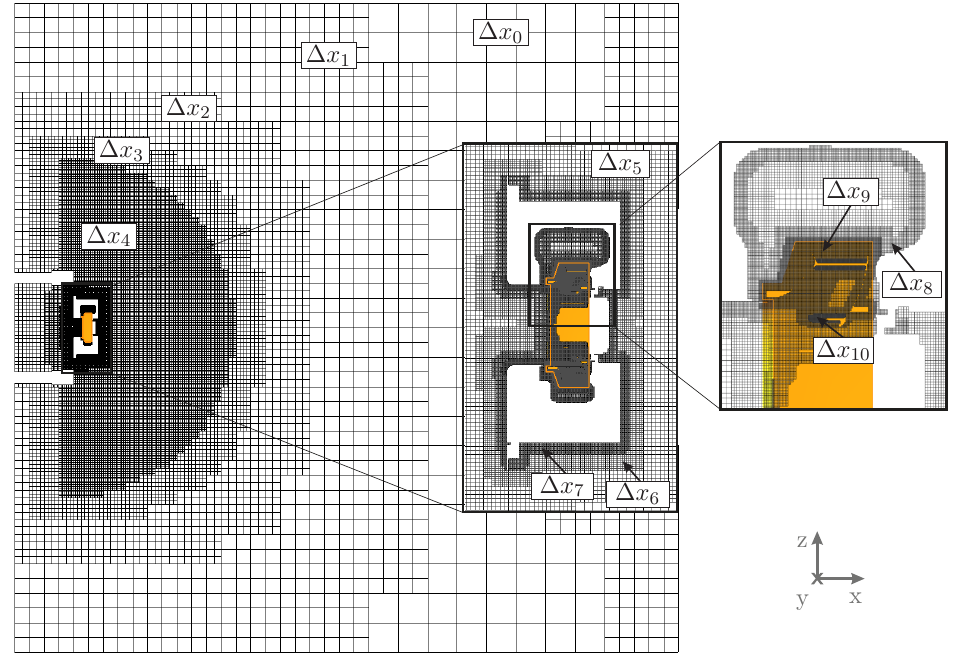
Figure 5. Mesh topology, the orange area indicates the local reference frame (LRF)